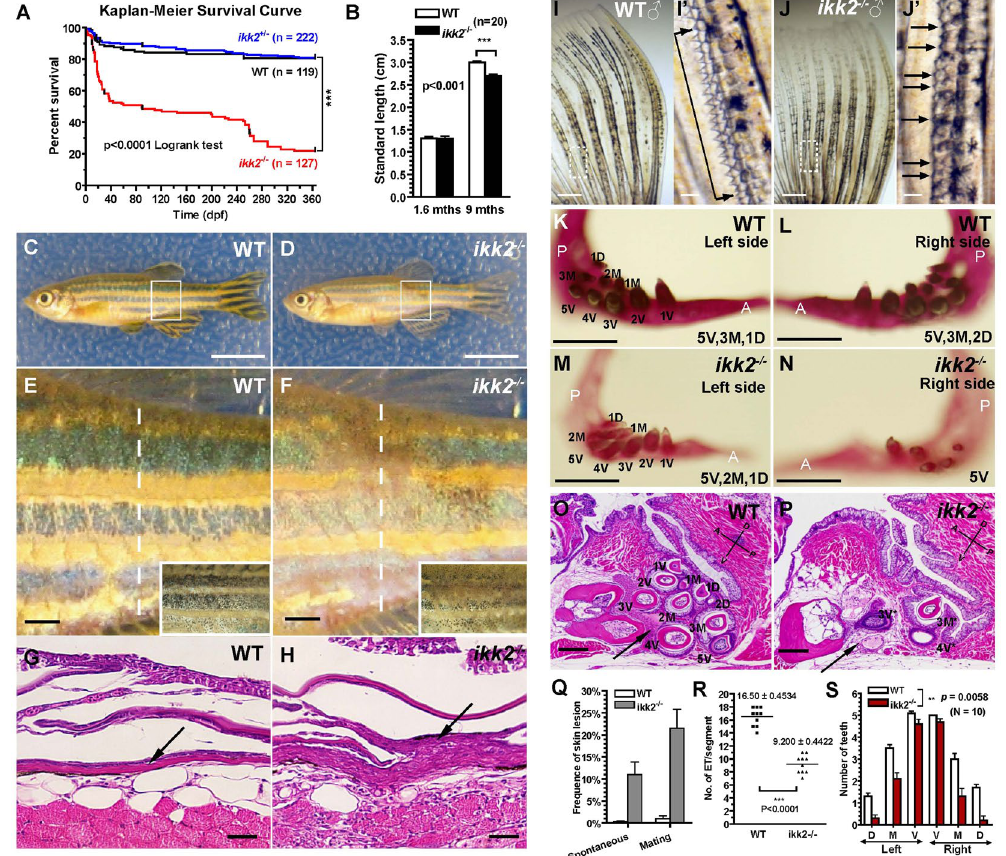
Figure 4. Ikk2 regulates development of skin and its appendages. ( A ) Kaplan-Meier analysis of survival of ikk2 − / − fish during one-year period. P < 0.001, by Logrank test. ( B ) Nine months-old adult ikk2 − / − (zygotic) mutants obtained from heterozygotic parents are small. P < 0.001, unpaired t test. ( C – F ) Adult ikk2 − / − fish are hypopigmented (boxed area and inset, E,F). They succumb to skin injuries without or with mating, with an average frequency of 11% and 21.5%, respectively. Scale bar in ( C , D) : 1 cm; in ( E , F) : 1000 µ m. ( Q ). ( E , F ) blowup of white rectangle area in ( C , D) . In severe cases, the injuries cause skin lesion. ( G , H ) H&E stained cross-section at the level of skin lesion area (dashed line in C , D ). Scale bar: 500 µ m. ( I , J ) Epidermal tubercles (ET) were reduced in ikk2 − / − . ( I ′ , J ′ ) Blowup of white rectangle area in ( I,J ). Quantifications by unpaired t test were shown in ( R ) Scale bar in I,J: 500 µ m; in ( I ′ , J ′ ): 100 µ m. ( K – N ) Alizarin red staining of teeth. Scale bar: 500 µ m. ( O , P ) H&E stained sagittal section at the Vth branchial arch. Teeth numbers were marked by * . Note that in ikk2 − / − fish, 4 V * was absent, 3 V * was defective, and blood supply to the dentation area (arrow) compromised. Scale bar: 100 µ m. ( S ) Teeth number was significantly reduced in adult mutants. P = 0.0058, paired t